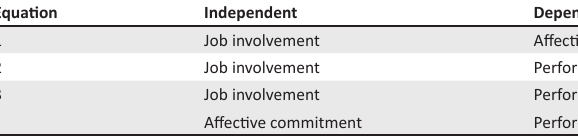
TABLE 3: Mediation test for affective commitment.